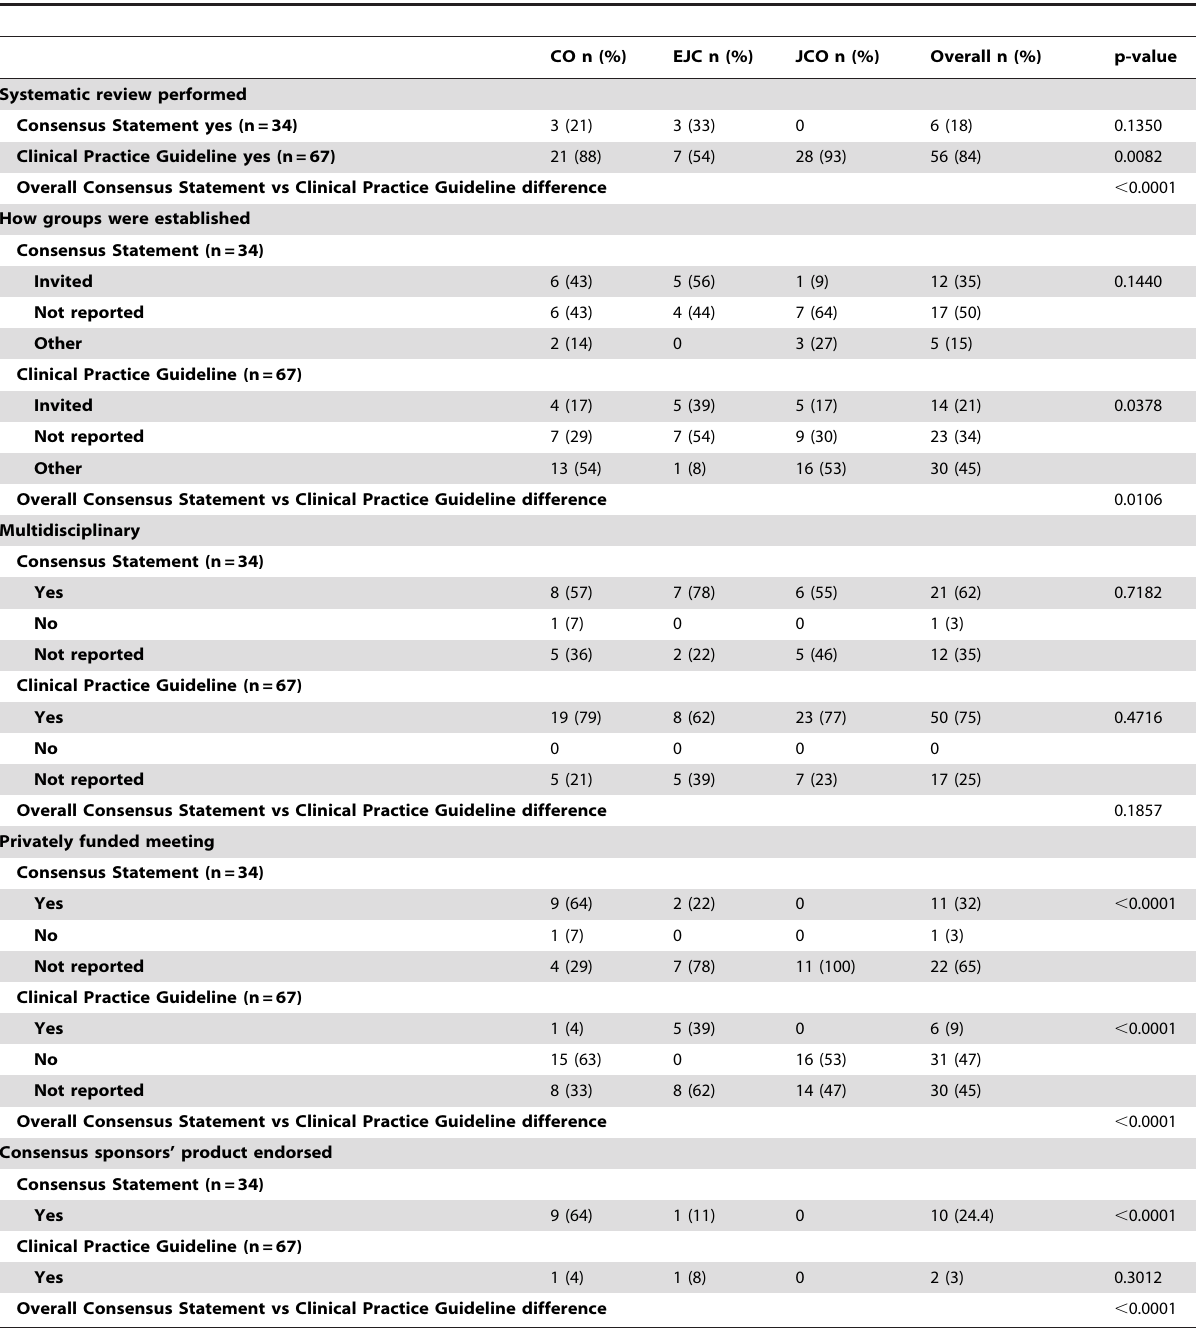
Table 3. Additional items addressing Transparency of Document